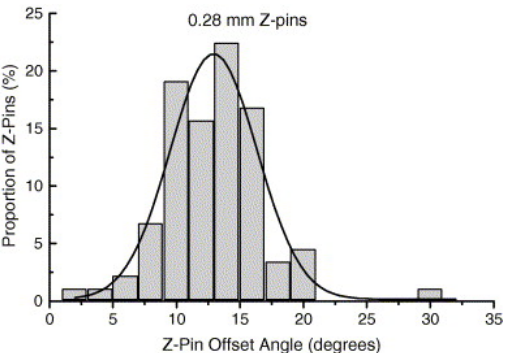
Figure 9. Distribution plot of percentage of z-Pins inclined at various angles from the orthogonal F igure 9. Distribution plot of percentage of direction (defined as θ / θ = 0 ◦ ) [11]. z-Pins inclined at various angles from the F igure 8. Fiber crimp and z-Pin offset orthogonal direction (defined as θ / θ = 0°) angle (defined as φ ) [18]. [11].